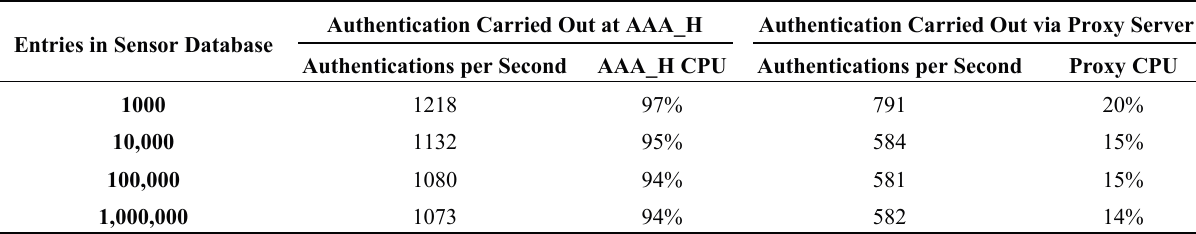
Table 3. FreeRadius AAA server performance benchmark running EAP-Swift directly and via proxy (as shown in Figure 9). Maximum number of authentications per second